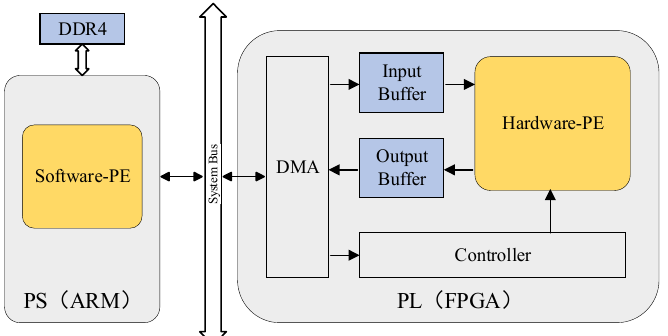
Figure 8. The overall architecture. FPGA: field programmable gate array. DDR is the abbreviations of double data rate synchronous dynamic random-access memory; PS is the abbreviations of processing system; PL is the abbreviations of programmable logic; PE is the abbreviations of processing element; DMA is the abbreviations of direct memory access.